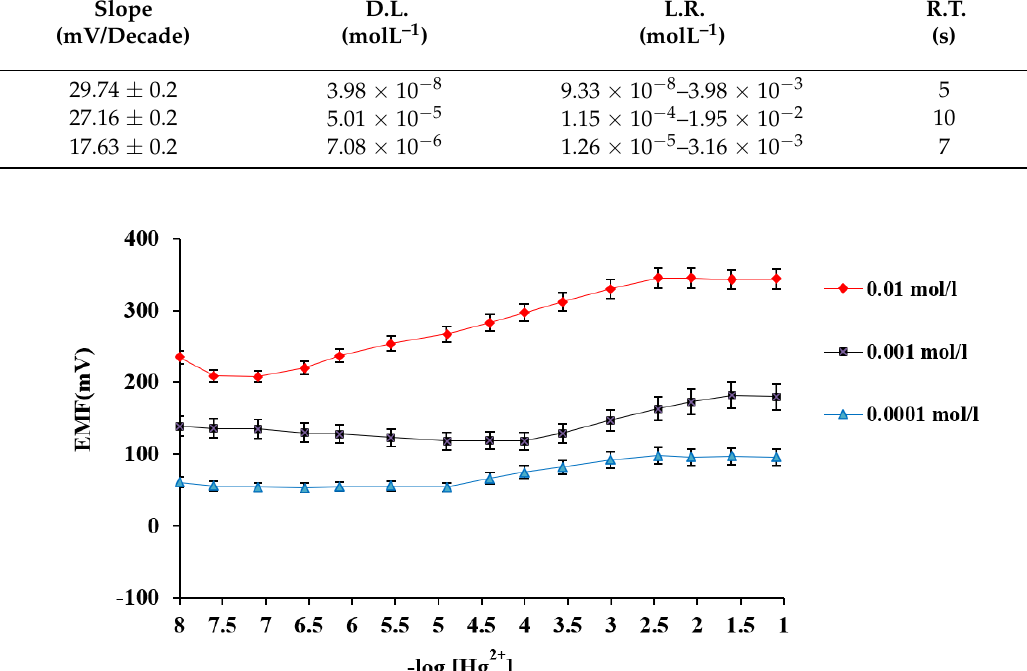
Figure 6. The relation between − log [Hg 2+ ] and the potential of Hg 2+ –SE at different concentrations of internal solution.